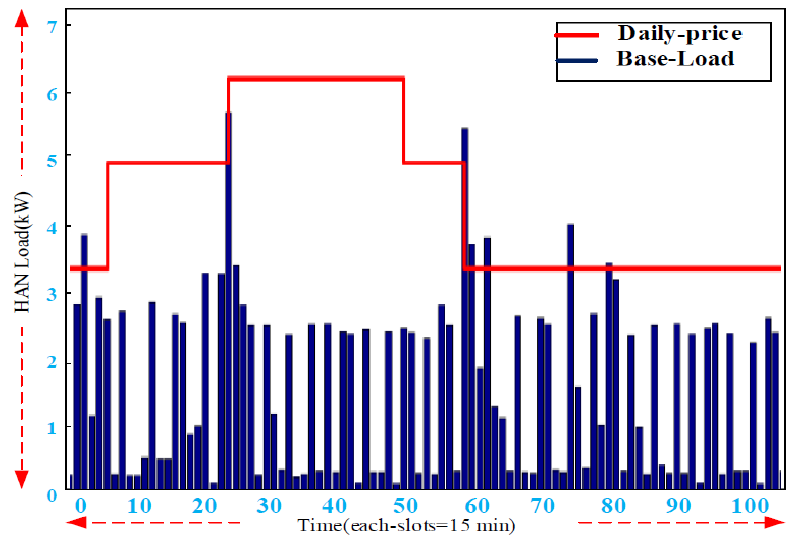
Figure 10. Total HAEMS load in the ground state.